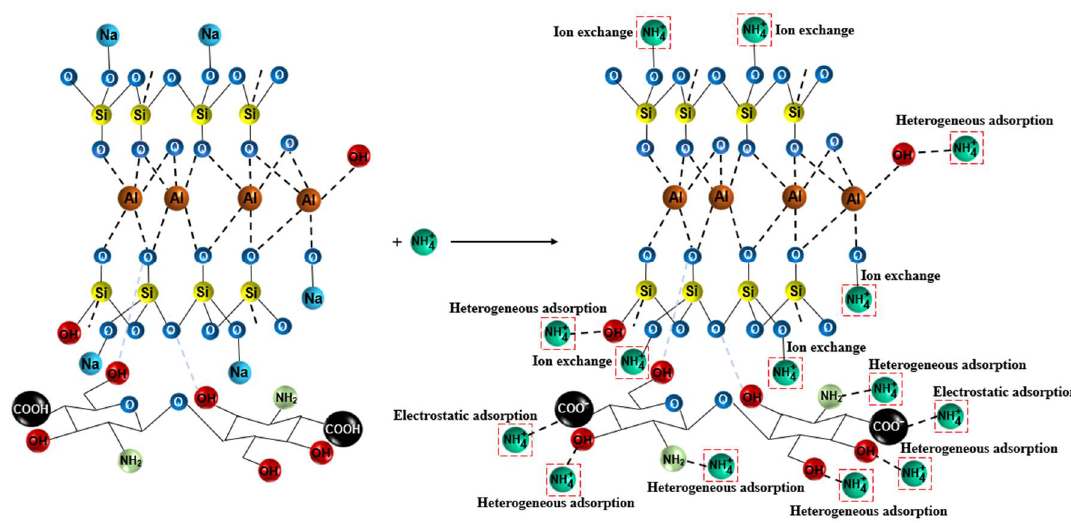
Figure 7. Adsorption mechanism of CTS-ZMS for ammonium nitrogen adsorption.